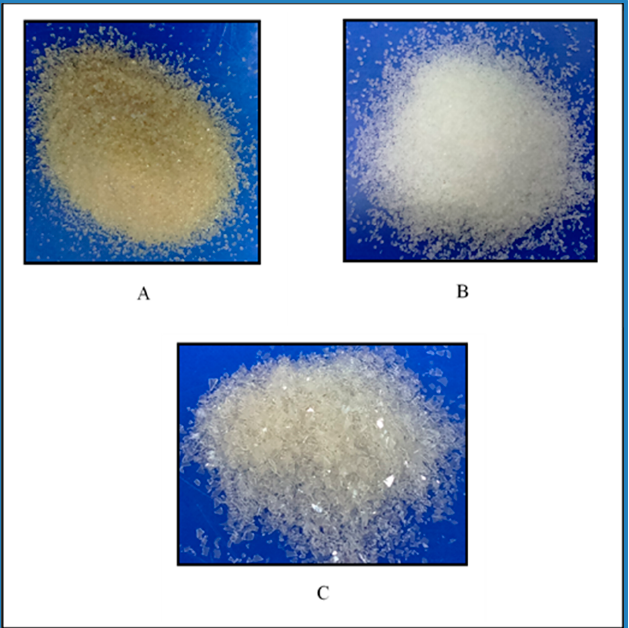
Figure 1. Gelatin extracted from goatskin compared to porcine gelatin and bovine gelatin. ( A ) Bovine gelatin; ( B ) porcine gelatin; ( C ) goatskin gelatin .